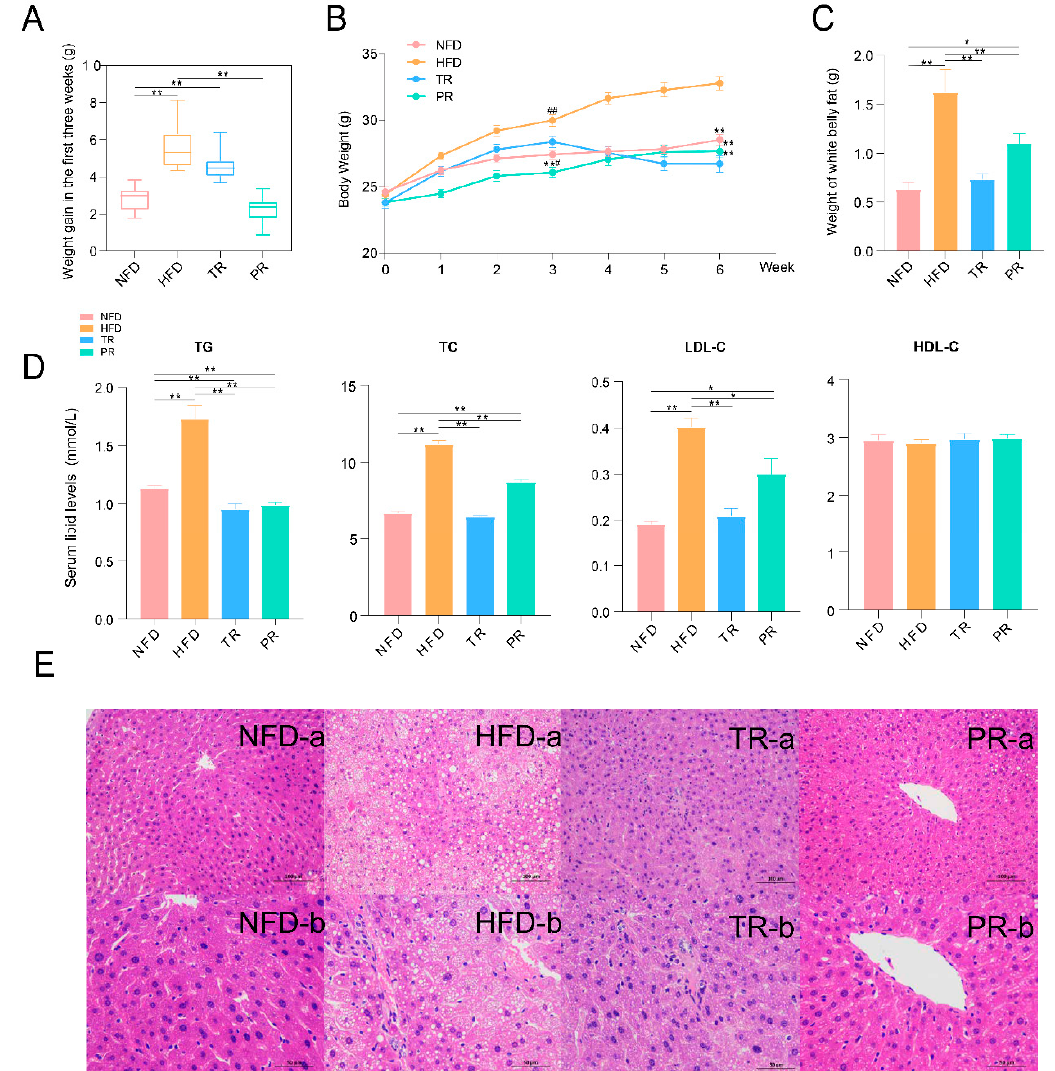
Figure 4. Effect of Jackfruit seed sourced resistant starch (JSRS)plus Bifidobacterium pseudolongum on hyperlipidemia in mice. ( A ) Body weight of four groups at each time point in Stage II. (Wilcoxon rank-sum test, * p < 0.05, ** p < 0.01 compared with HFD; # p < 0.05, ## p < 0.01 compared with NFD, error bar: mean ± SE) ( B ) Weight gain was compared between the four groups during the first three weeks of the study at each time point in Stage II (Wilcoxon rank-sum test, * p < 0.05, ** p < 0.01, NS means no significant difference, error bar: mean ± SE) ( C ) Comparison of the weight of white fat in the abdomen of four groups of mice. (Wilcoxon rank-sum test, * p < 0.05, ** p < 0.01, error bar: mean ± SE) ( D ) Comparison of TC, TG, LDL-C, and HDL-C levels among the four groups in Stage II. (Wilcoxon rank-sum test, * p < 0.05, ** p < 0.01, error bar: mean ± SE) ( E ) Histopathological analysis of the liver sections of mice in four groups at 200× and 400× magnification in Stage II. (“-a” and “-b” were liver section images at the same position, but with different magnification. “-a” means 200×; “-b” means 400×).